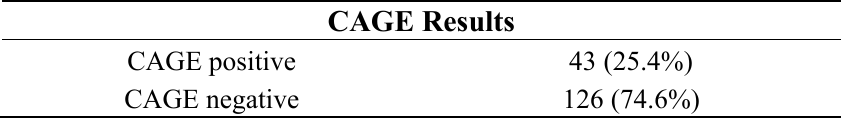
Table 1. CAGE results.